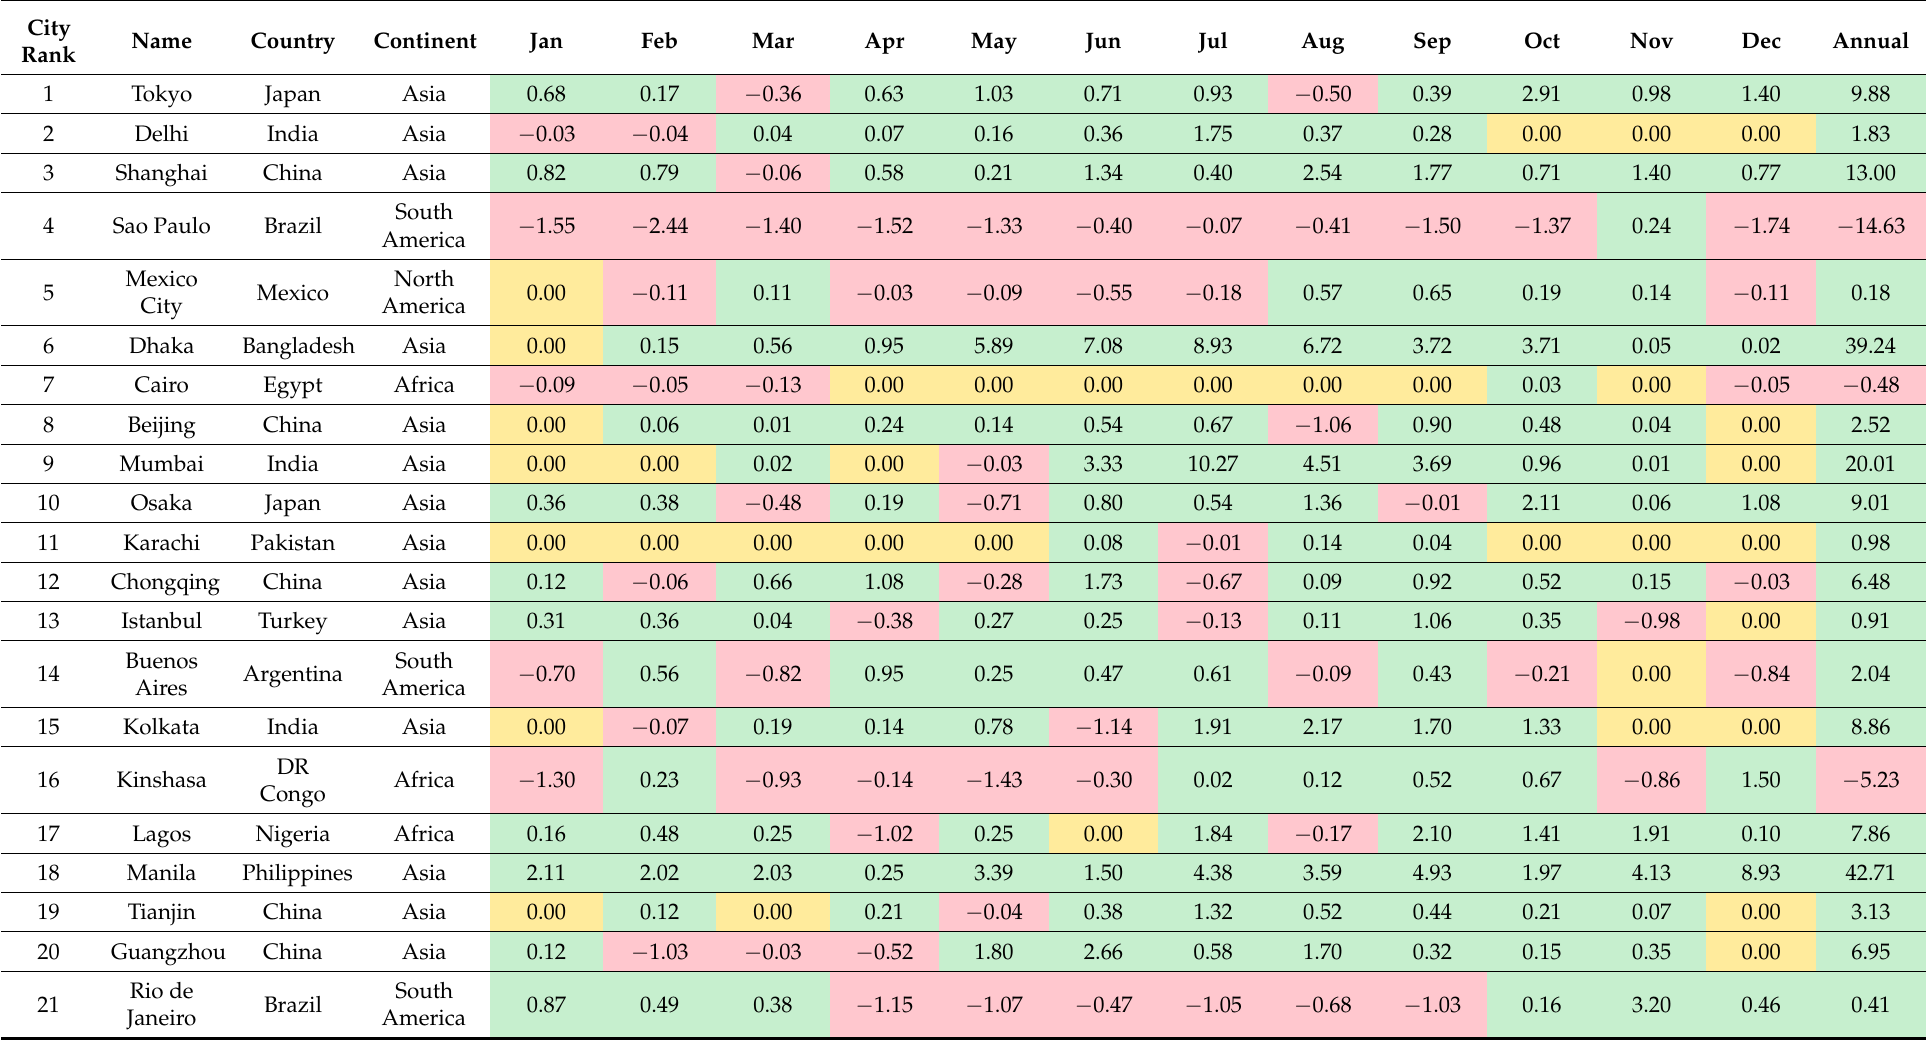
Table 3. Monthly and annual Sen’s Slope Value from Modified Mann–Kendall